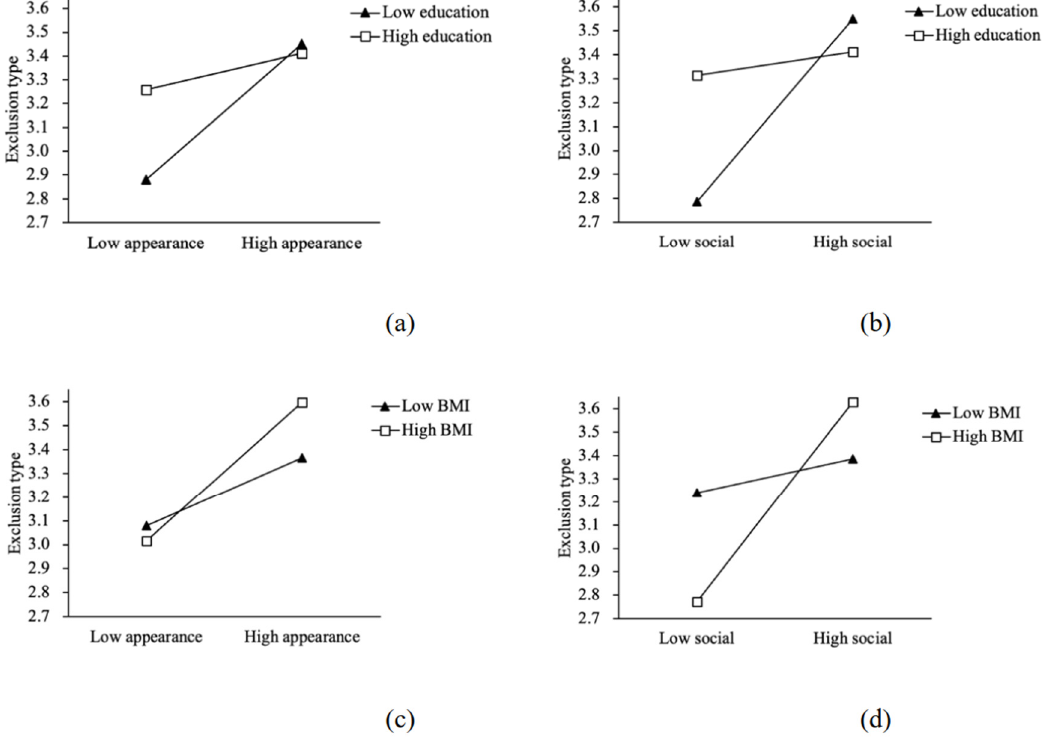
Figure 2. Diagram of the moderating effect. Note: ( a , b ) describe the moderating effect of education level on image construction to predict exclusion waste behavior; ( c , d ) describe the moderating effect of body mass index on image construction to predict exclusion waste behavior.